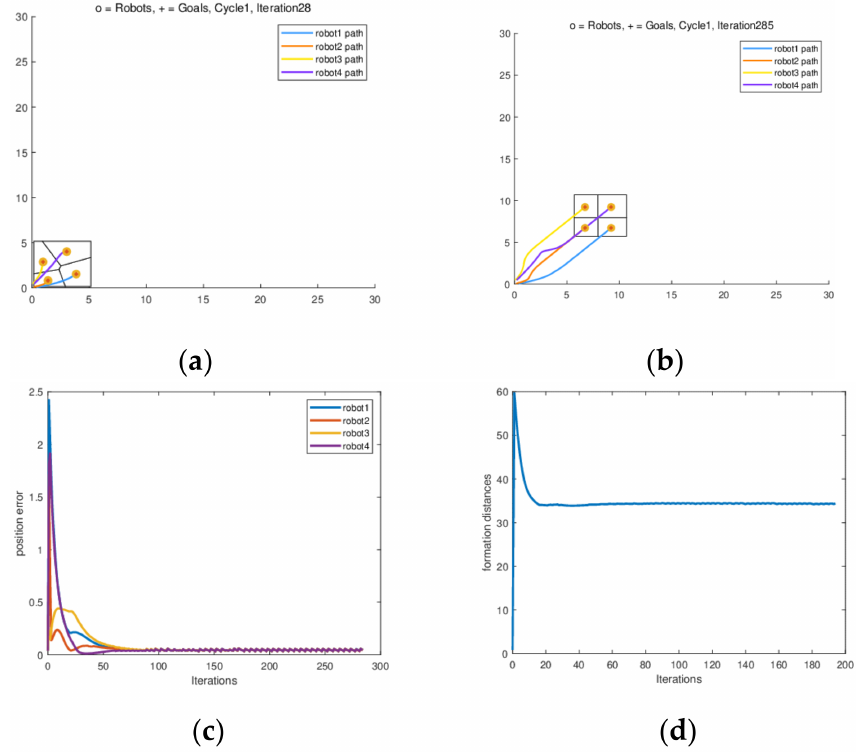
Figure 8. Dynamic formation simulation under the obstacle-free scenario: ( a ) k = 28; ( b ) k = 285; ( c ) position error; ( d ) formation